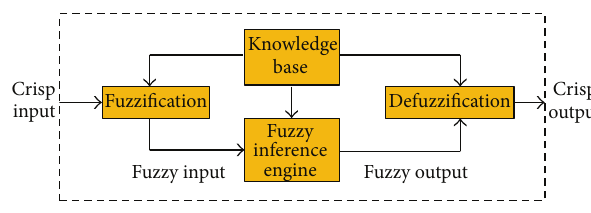
Figure 8: Fuzzy logic controller